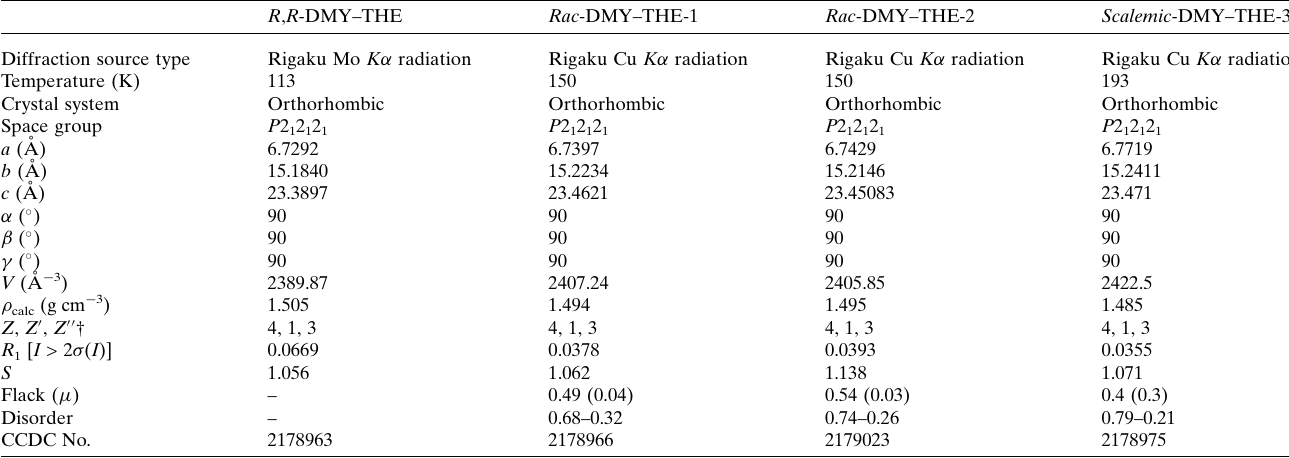
Table 2 Crystallographic data of the DMY–THE cocrystal.